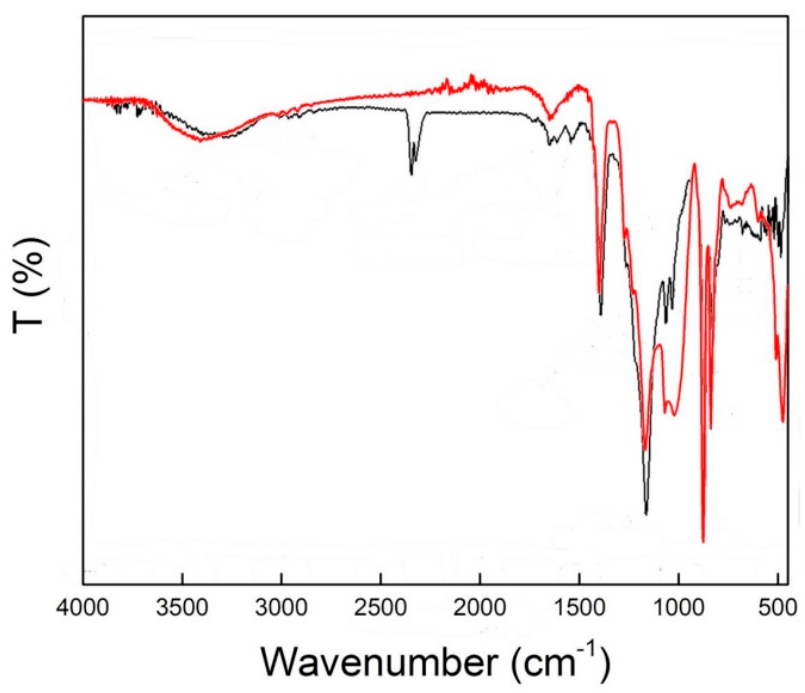
Figure 10. ATR-IR transmission spectrum of the PVIB-10 anion-exchange membrane before use (black) and after extensive use (red).